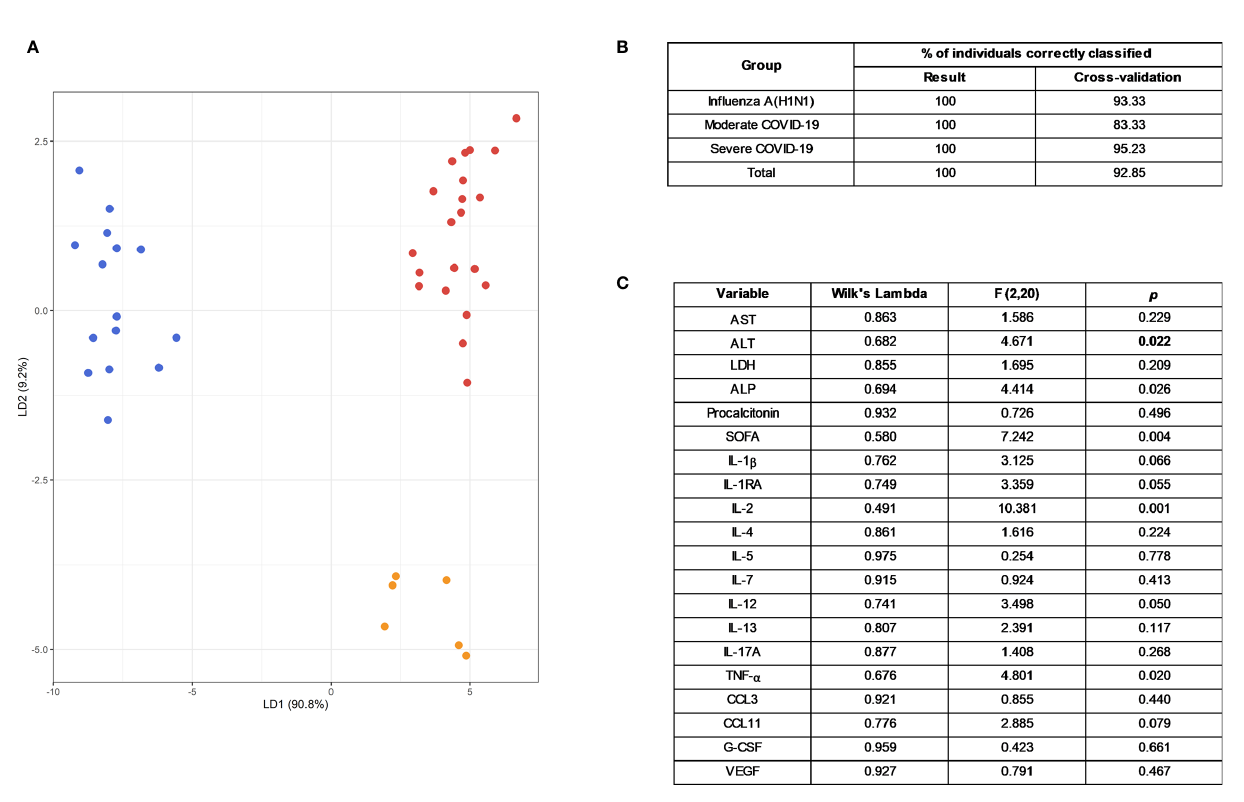
FIGURE 5 | Selected clinical and immunological characteristics that better distinguish pandemic in fl uenza A(H1N1) from COVID-19. (A) Linear discriminant analysis (LDA) plot of the fi rst two discriminant functions showing the separation of the different groups of study participants according to a set of selected clinical and immunological characteristics used in combination. Each dot represents a single individual, and each color represents a group of participants: blue for pandemic in fl uenza A(H1N1), orange for moderate COVID-19, and red for severe COVID-19. (B) Accuracy of the LDA results before and after a “ leave-one-out ” cross- validation. (C) The discriminant potential of each individual variable included in the LDA was estimated using the Wilk´s Lambda test. The table displays values of Wilk´s lambda, F, and p for each